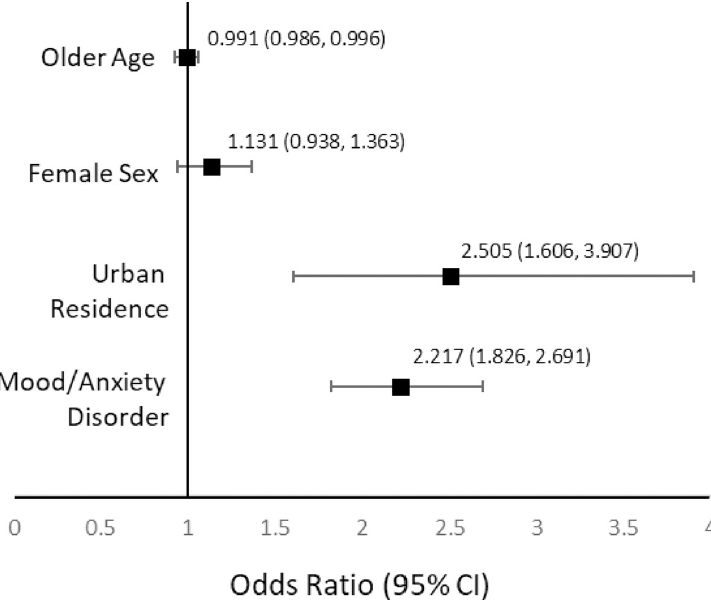
Fig 2. Variables predicting pharmacotherapy use among individuals with alcohol use disorder. Odds Ratio with 95%